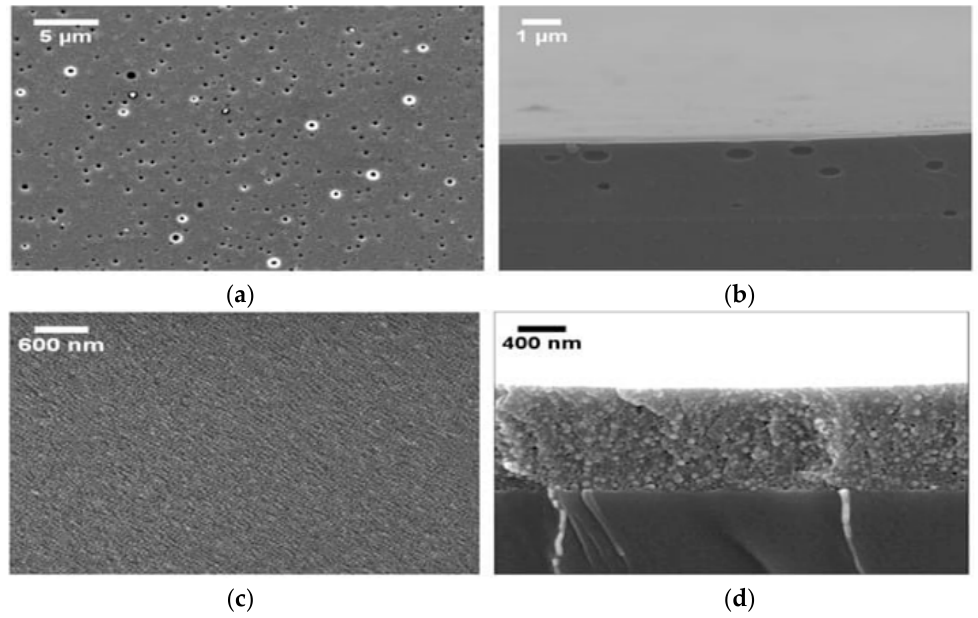
Figure 7. SEM images of as-received coupons with A in: ( a ) planar view revealing surface defects and ( b ) cross-sectional view showing the presence of voids, and B in ( c ) planar view, ( d ) cross-sectional view showing no defect [44].